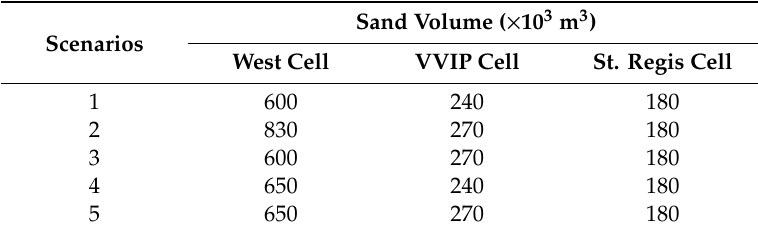
Table 3. Summary of the five design